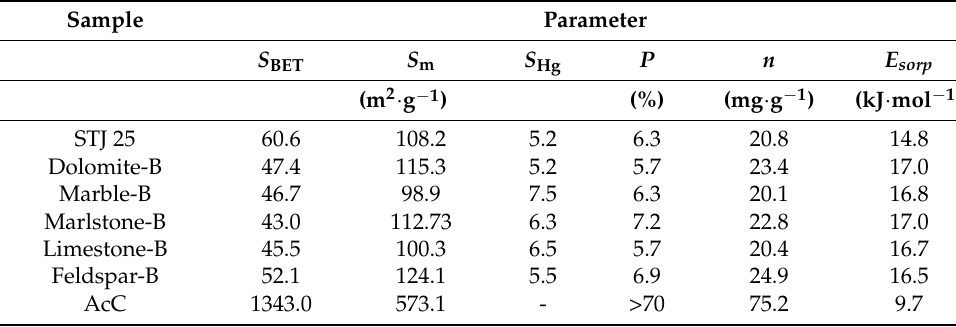
Table 5. Textural and sorption